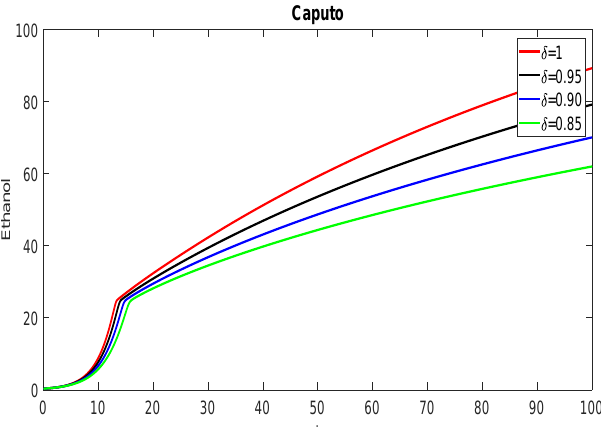
Figure 2. Evolution of the substrate, biomass, and ethanol for fractal dimension 0.9 and different fractional orders in Caputo sense.